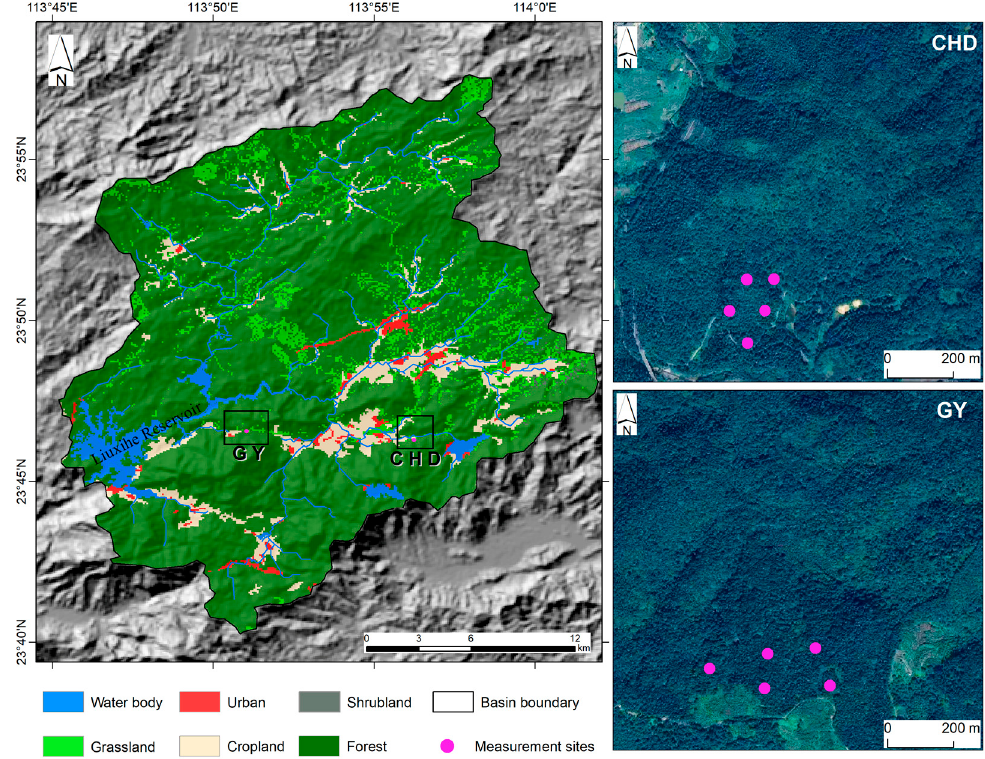
Figure 1. Location of the Guo Yuan (GY) and Chenhe Dong (CHD) within the LXH national forest park. The purple points in the Google Earth images represent the independent measurement sites of the FCO 2 . The grey background represents the topography, which is obtained from the Shuttle Radar Topography Mission Digital Elevation Model (SRTM DEM, 30 m) (http://www.gscloud.cn (accessed on 21 October 2020)).